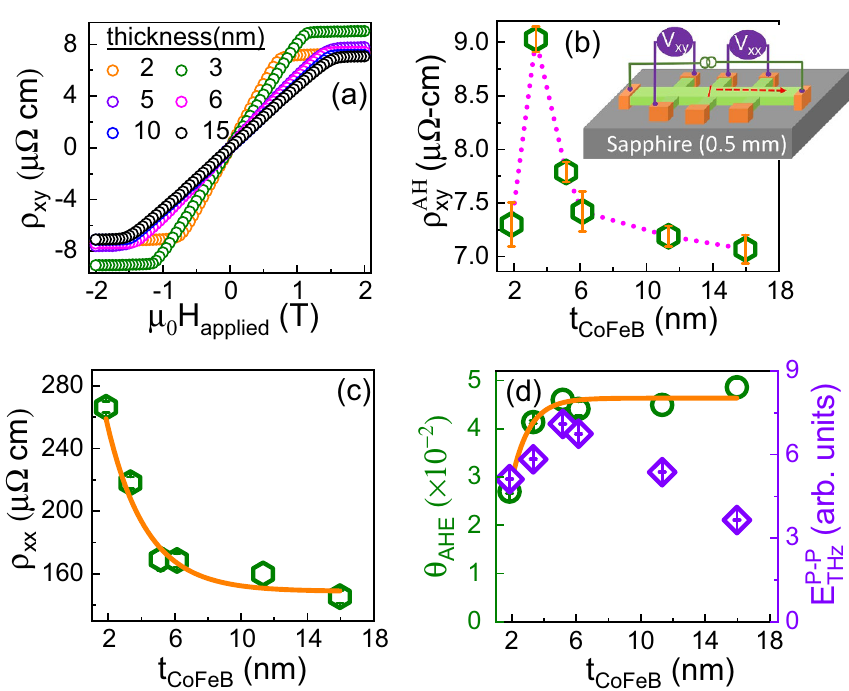
Figure 4. Results from Hall ( ρ xy ) and longitudinal ( ρ xx ) resistivity measurements on CoFeB films with different thickness. ( a ) ρ xy vs. applied magnetic field ( µ 0 H applied ) , ( b ) ρ AH xy vs. t CoFeB where ρ AH xy corresponds to the saturation value of ρ xy , ( c ) ρ xx vs. t CoFeB , and ( d ) THz peak-to-peak amplitude (right y-axis) and anomalous Hall angle (left y-axis) vs. t CoFeB